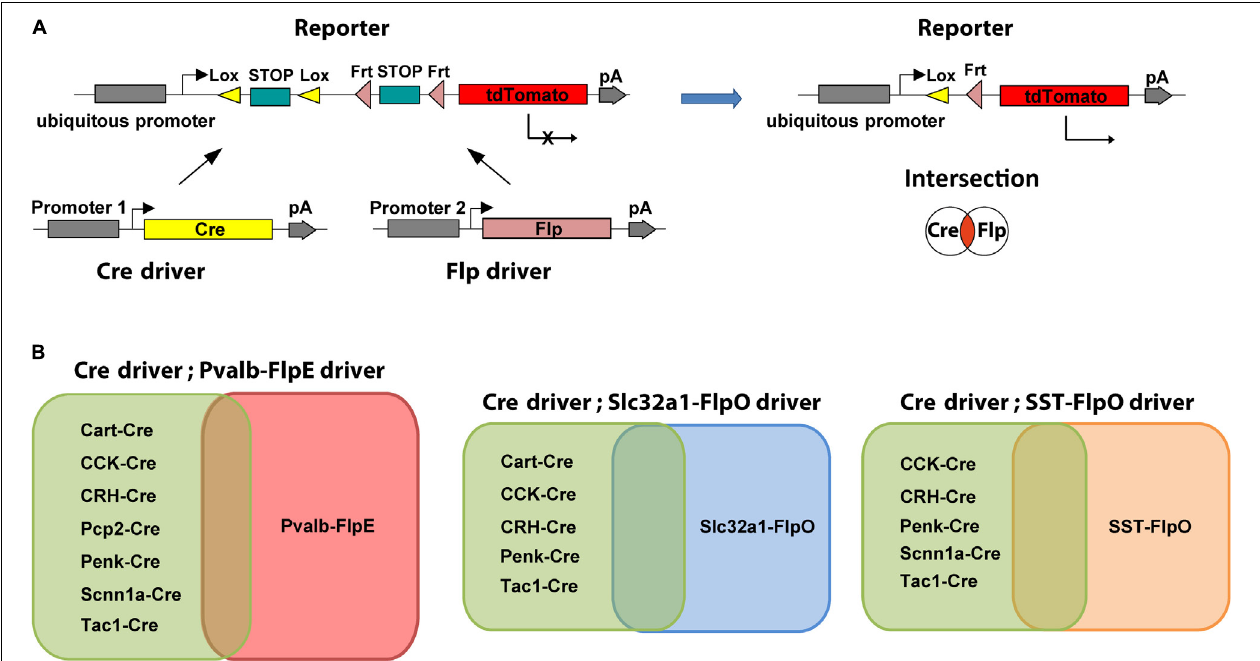
FIGURE 1 | Intersectional strategy with Cre/Flp dual recombinase. (A) Schematic diagram of the intersectional strategy with Cre/Flp dual recombinase. The Cre driver line uses gene specific promoter 1, the Flp driver line uses gene specific promoter 2, and the double reporter uses a ubiquitous promoter (left). Expression of tdTomato in the reporter line ( Ai65 ) is prevented by lox- and frt-flanked STOP cassettes. Following removal of both STOP cassettes, tdTomato is expressed in the cells that are in the overlap or “intersection” of the two populations of neurons targeted by either the Cre driver or the Flp driver (right). (B) Intersectional strategies provide flexibility for targeting specific cell types. Each Flp line can be crossed with many Cre lines to create multiple